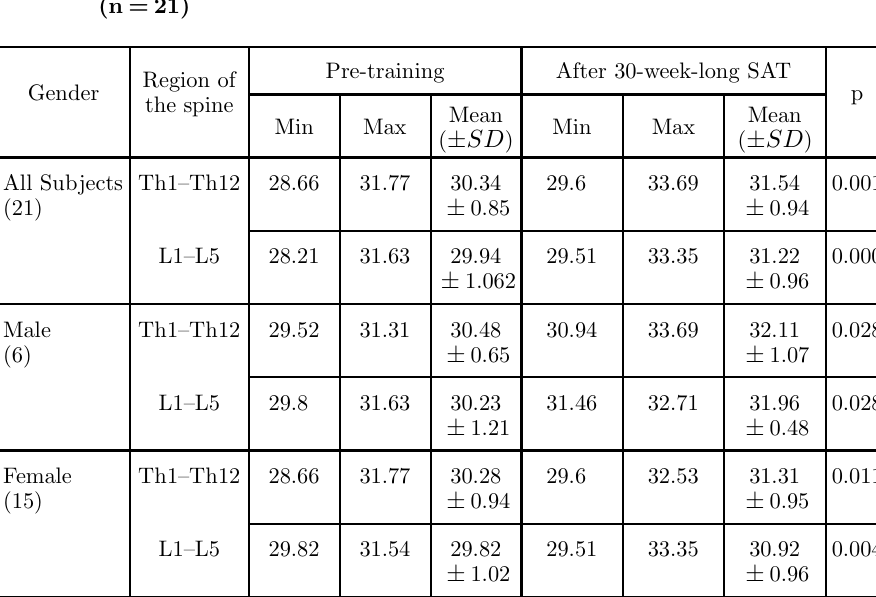
Table 3. Descriptive statistics of differences in the temperature of deep spine muscles (Th1–Th12 and L1–L5) pre-training and after week 30 of SAT (n = 21) Pre-training After 30-week-long SAT Region of Gender p the spine Mean Mean Min Max Min Max ( ± SD ) ( ± SD ) All Subjects 28.66 (21)